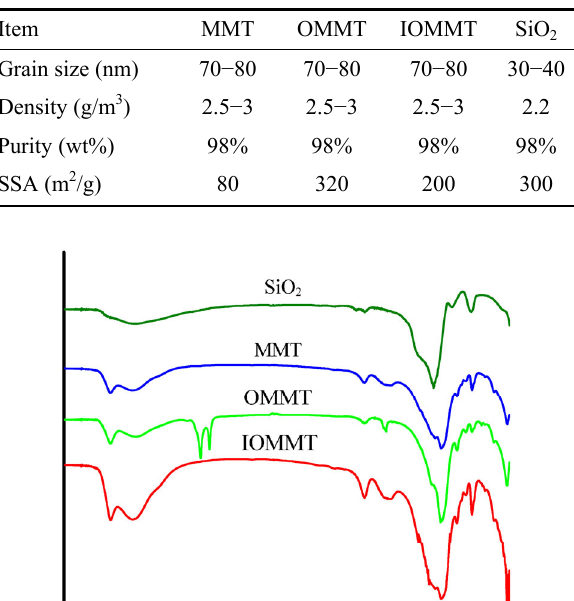
Table 2 Main characteristics of the nano-montmorillonite and nano-SiO 2 .